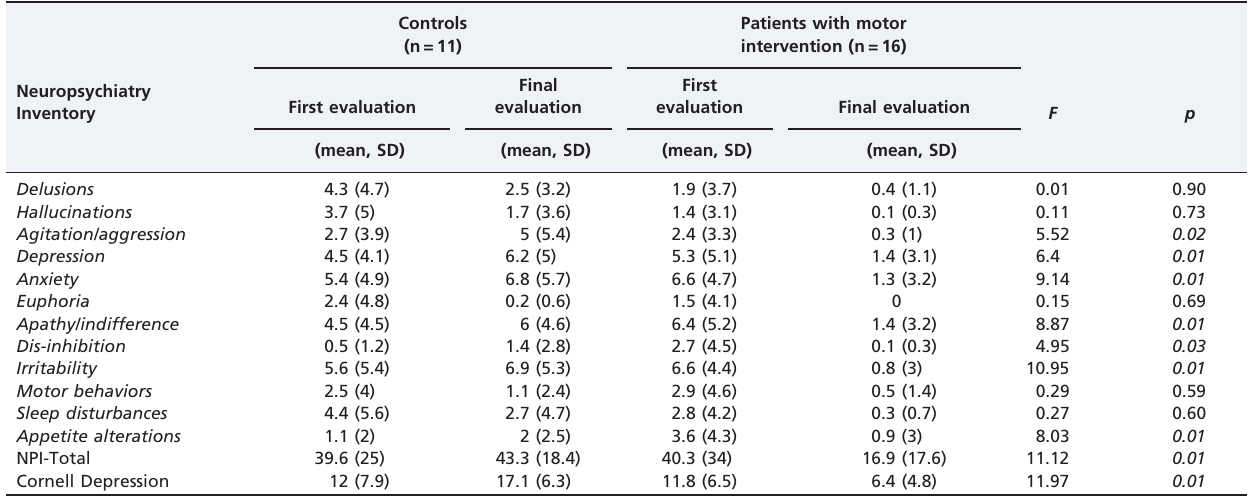
Table 2 - Neuropsychiatric symptoms according to Neuropsychiatric Inventory domains and the Cornell Scale for Depression in Dementia for patients with Alzheimer’s disease (significant values: mean and SD) at baseline and at the time of final evaluation, after six months of exercise.